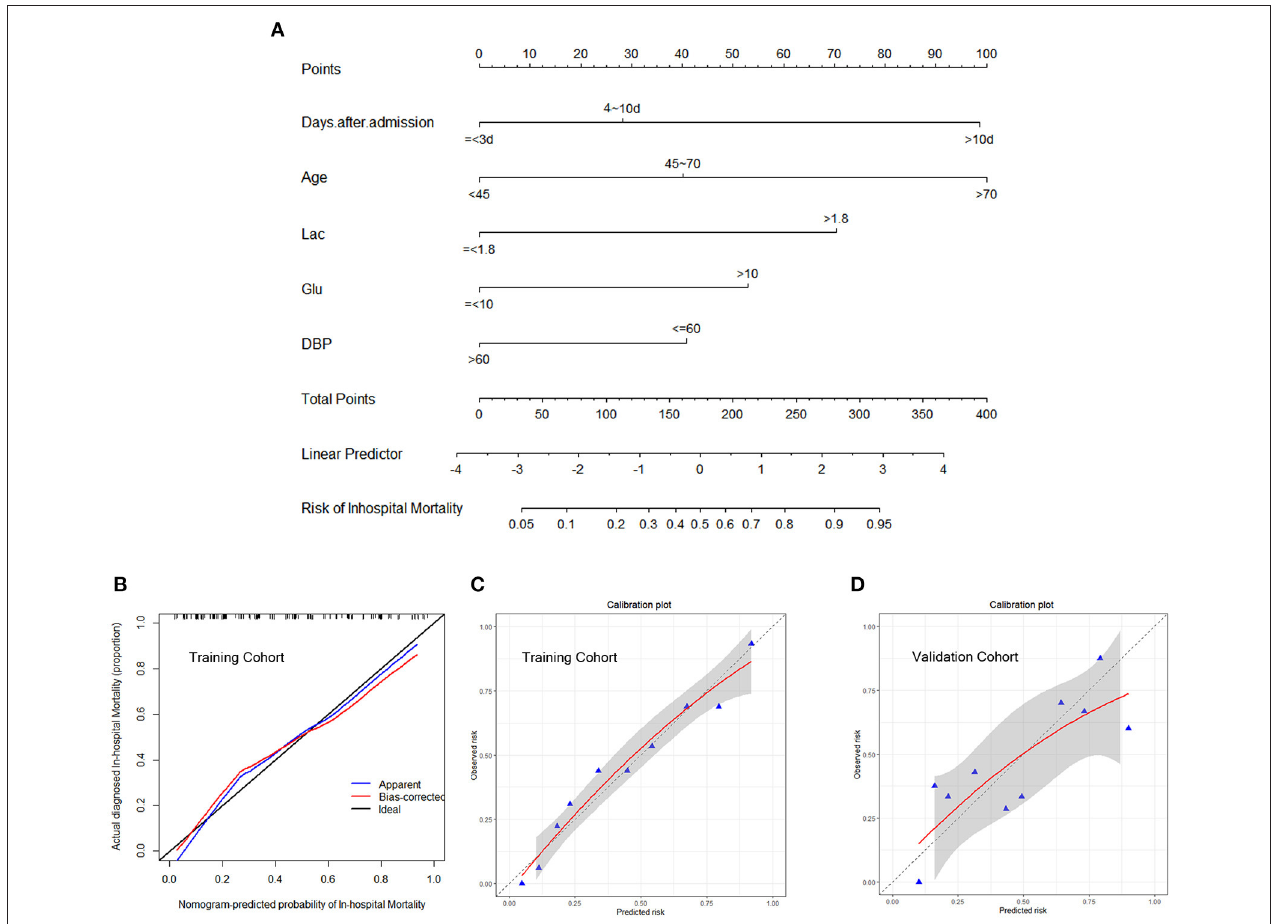
FIGURE 2 | Development predicting nomogram model. (A) The nomogram includes significant clinical characteristics for predicting in-hospital mortality in AHF patients undergoing CRRT. To estimate the in-hospital mortality rate of an individual patient, the value of each included significant clinical characteristic is acquired and divided into the different groups, followed by a line drawn straightly downward to determine the points. The sum of these five numbers is located at the Total Points axis, then a line is drawn downward to the risk of in-hospital mortality axes to determine the likelihood of in-hospital mortality. The calibration curve of the nomogram model for predicting in-hospital mortality was internally validated using the bootstrap validation method (B) and Hosmer–Lemeshow test (C) in the training cohort and externally validated using the Hosmer–Lemeshow test (D) in the validation cohort. The nomogram-predicted probability of in-hospital mortality is plotted on the x-axis, and the actual in-hospital mortality is plotted on the y-axis. The gray area both in c and d represents a 95% confidence interval. AHF, acute heart failure; CRRT, continuous renal replacement therapy; DBP, diastolic blood pressure; Lac, lactic acid.